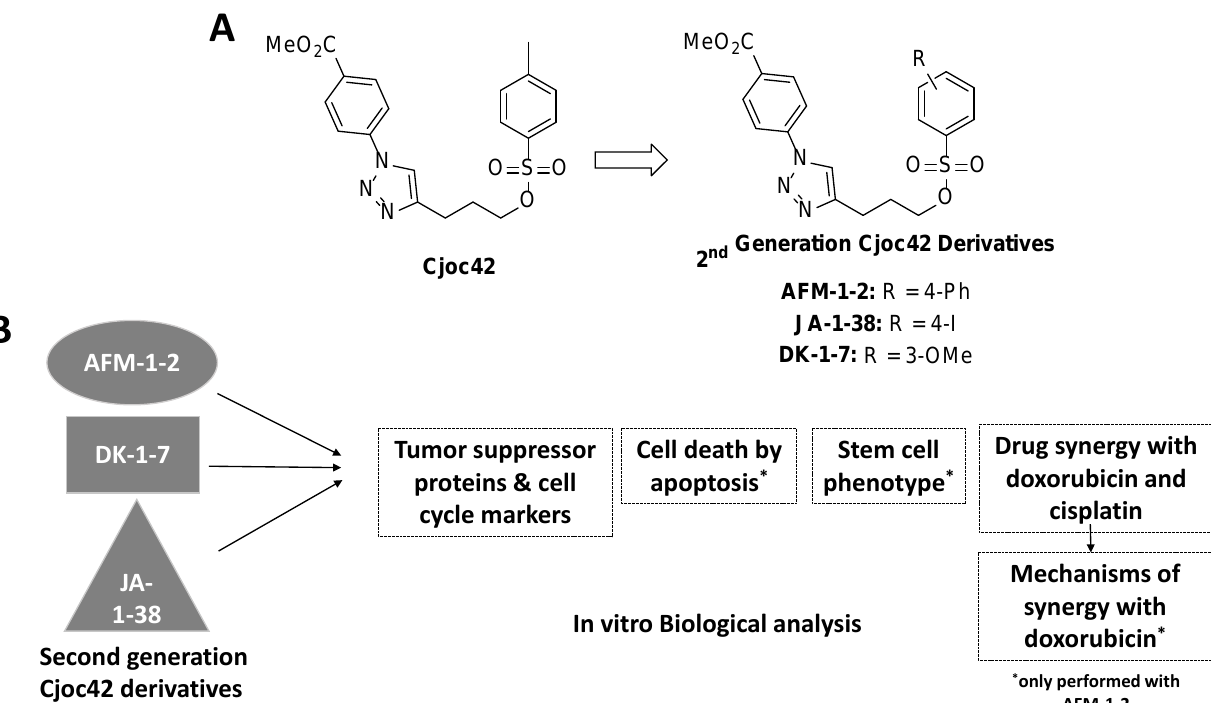
Figure 1. Review of Cjoc42 derivatives and the experimental design. ( A ) Chemical structure of the cjoc42 derivatives. ( B ) Graphical illustration of the experimental design with all three cjoc42